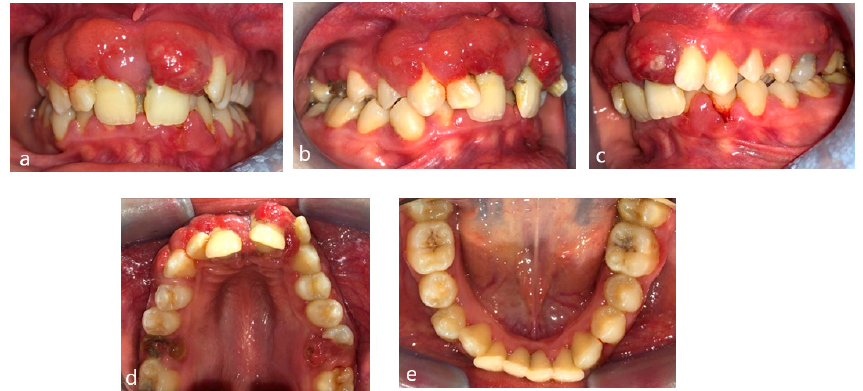
Figure 1. Clinical aspects before periodontal treatment: ( a ) frontal aspect, ( b ) right lateral aspect, ( c ) left lateral aspect, ( d ) maxillary occlusal aspect, and ( e ) mandibular occlusal aspect. The plaque index score registered and bleeding upon probing (BOP) were 100%. The initial probing depth (PD) was 10 mm at the left central incisors (mesial) and 8–9 mm at the other proximal sites of the both upper central incisors. The tooth mobility (Miller Classification) was Class 2 for both the maxillary central and lateral incisors (Figure